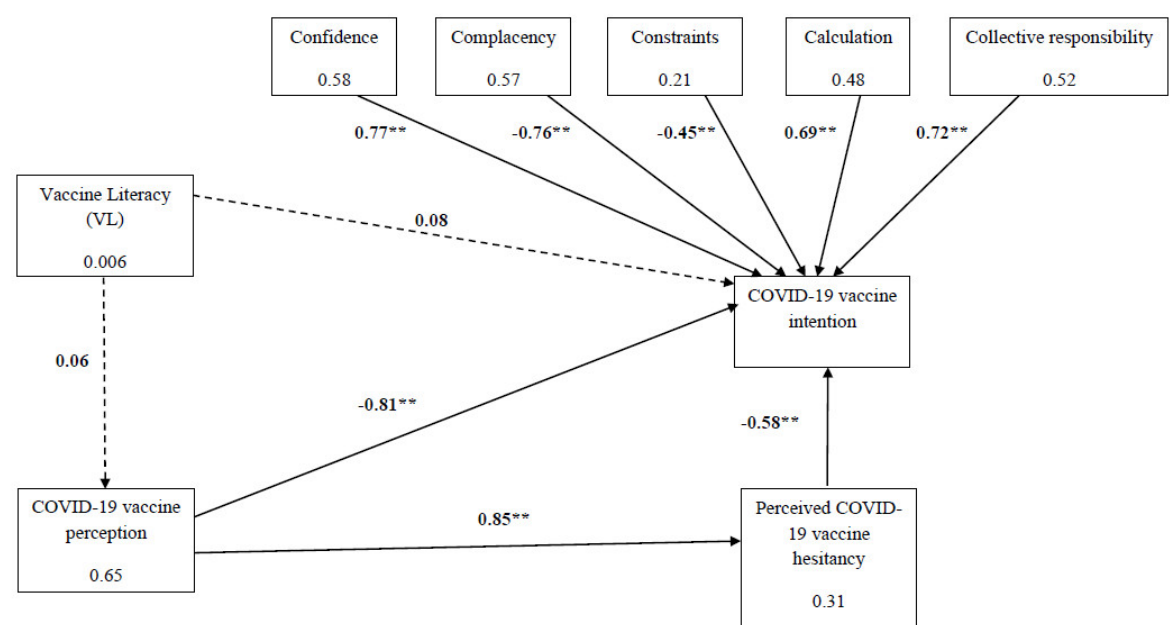
Figure 3. The effect of 5C, vaccine literacy, perceived vaccine hesitancy and COVID-19 vaccine perception on COVID-19 vaccination intention. Values on the errors are correlation coefficients ( β ) and values in the boxes are r 2 ; ** p < 0.001